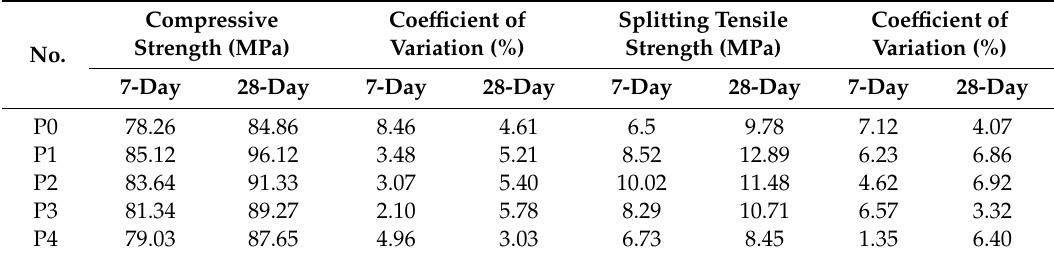
Table 8. Results of mechanical property test on polypropylene fiber RPC.